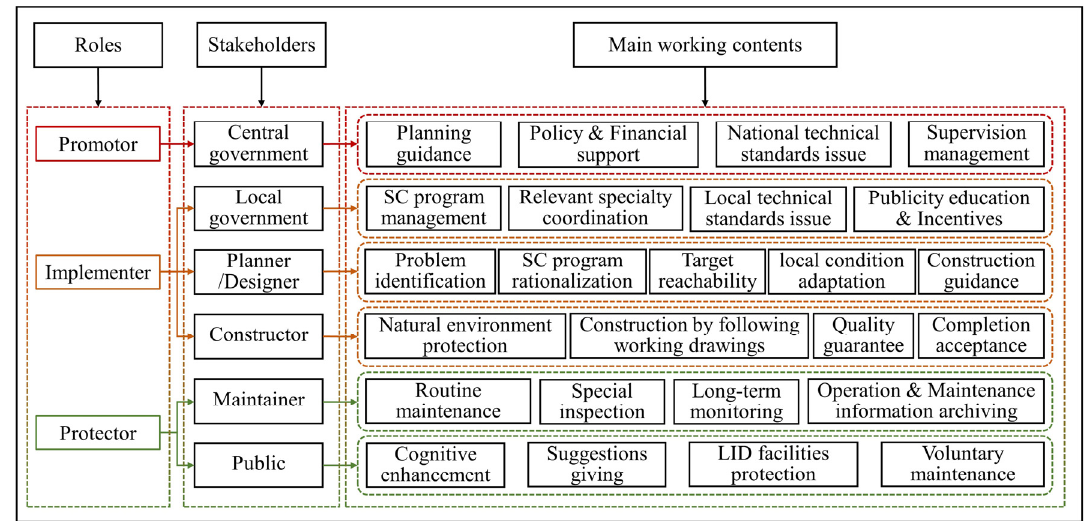
Figure 7. Main working contents for different stakeholders in sponge city